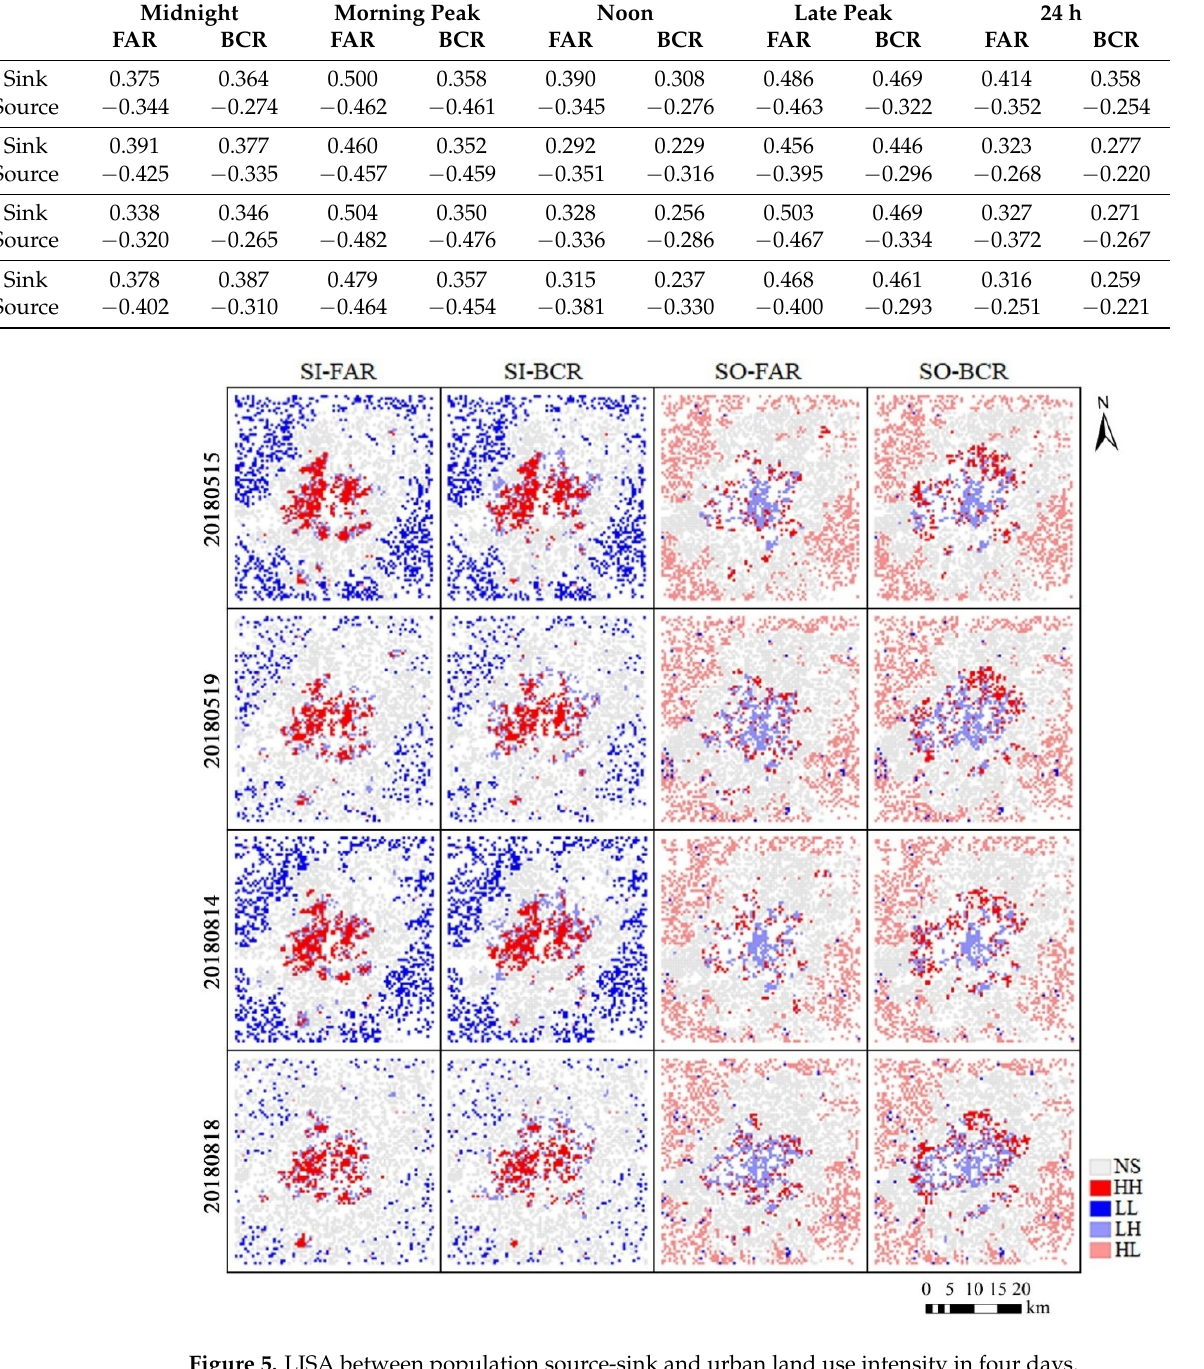
Figure 5. LISA between population source ‐ sink and urban land use intensity in four days.